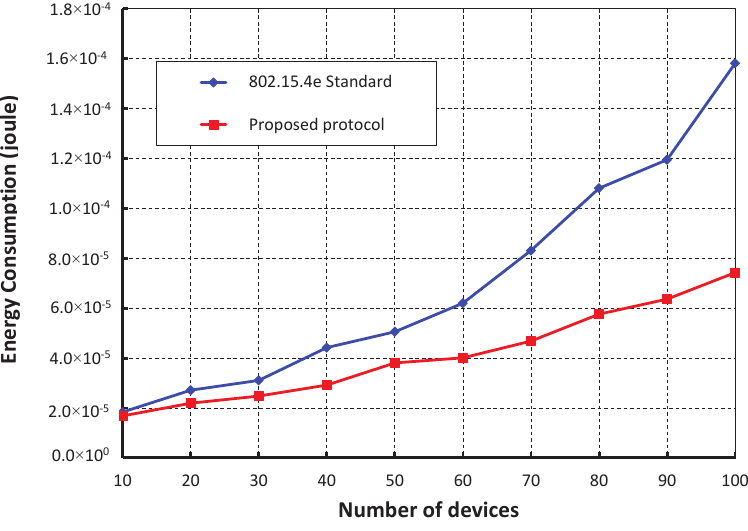
Figure 17. Comparison of energy consumption of our scheme with IEEE 802.15.4e